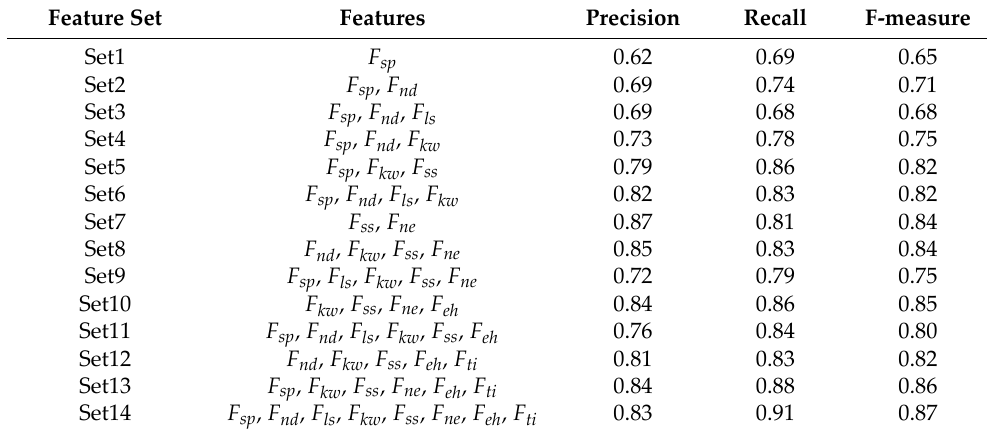
Table 9. Evaluation measure for 65% compression